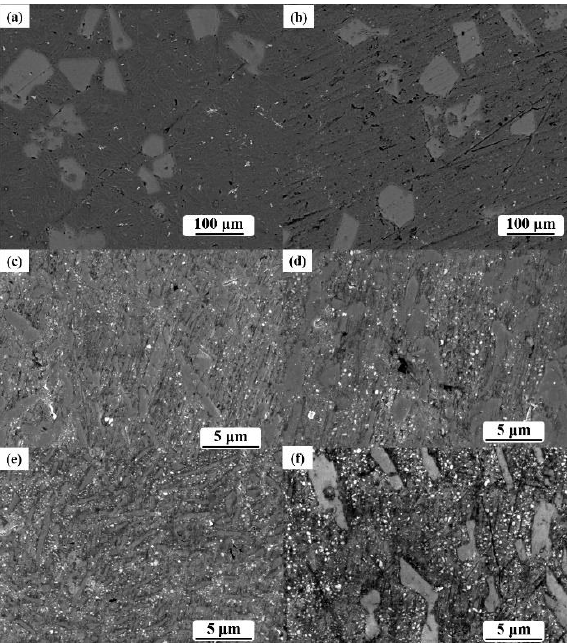
Figure 4. The microstructure of the 3C – SiC/MgAl 2 O 4 /Al composite in different phenolic resin addition: ( a ) blank sample; ( b , c ) 0.3% resin added; and ( d – f ) 0.9 – 2.1% resin-added samples.